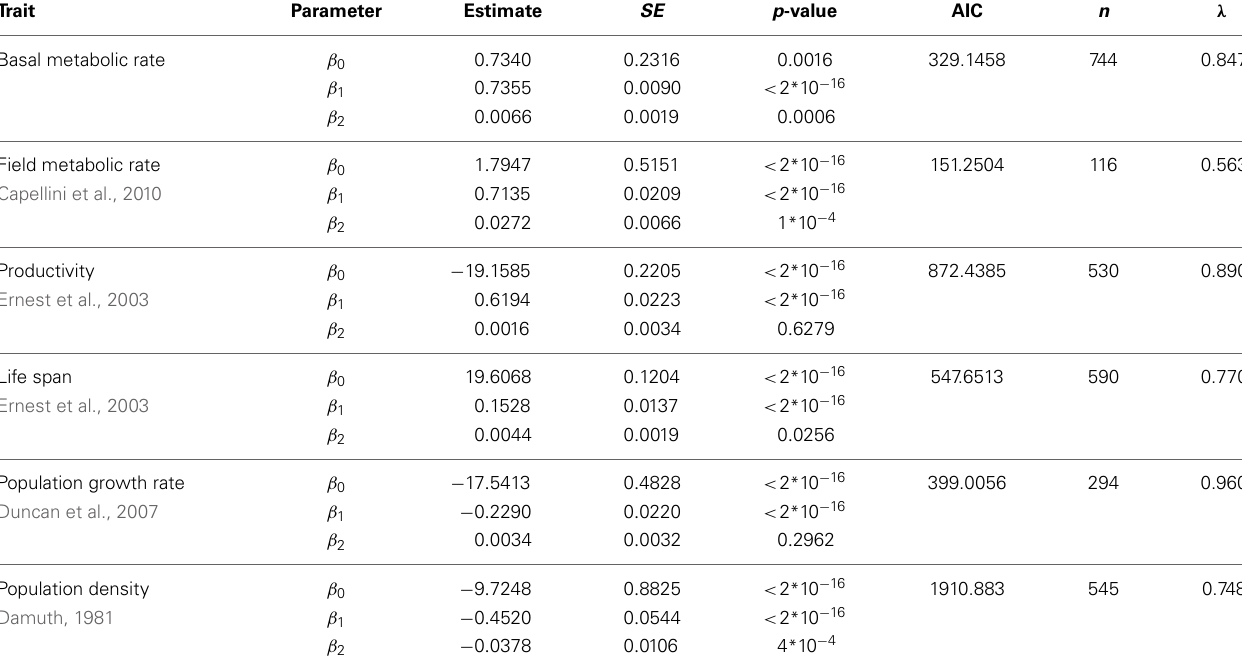
Table 5 | Fit of the data shown in right panels of Figure 2 of the main text using phylogenetic least squares